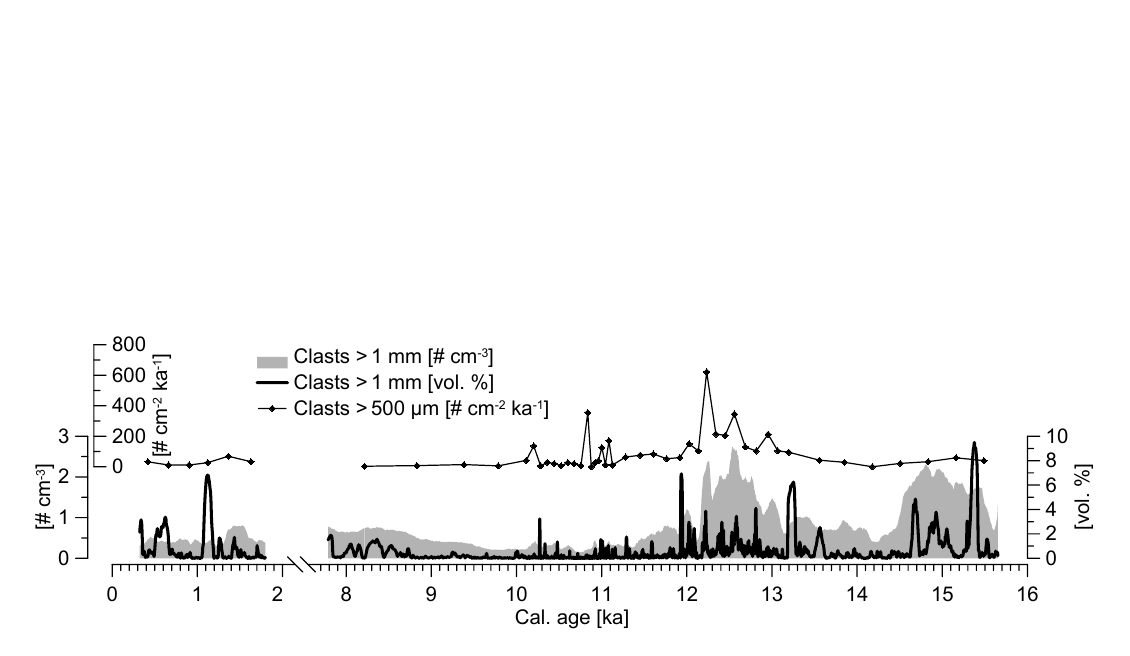
Figure A3. Comparison of methods to determine the input of ice-rafted debris (IRD): accumulation rates (Ehrmann and Thiede, 1985) of clasts >500µm based on count data as well as volume percentages and numbers of clasts (>1mm)cm − 3 based on CT